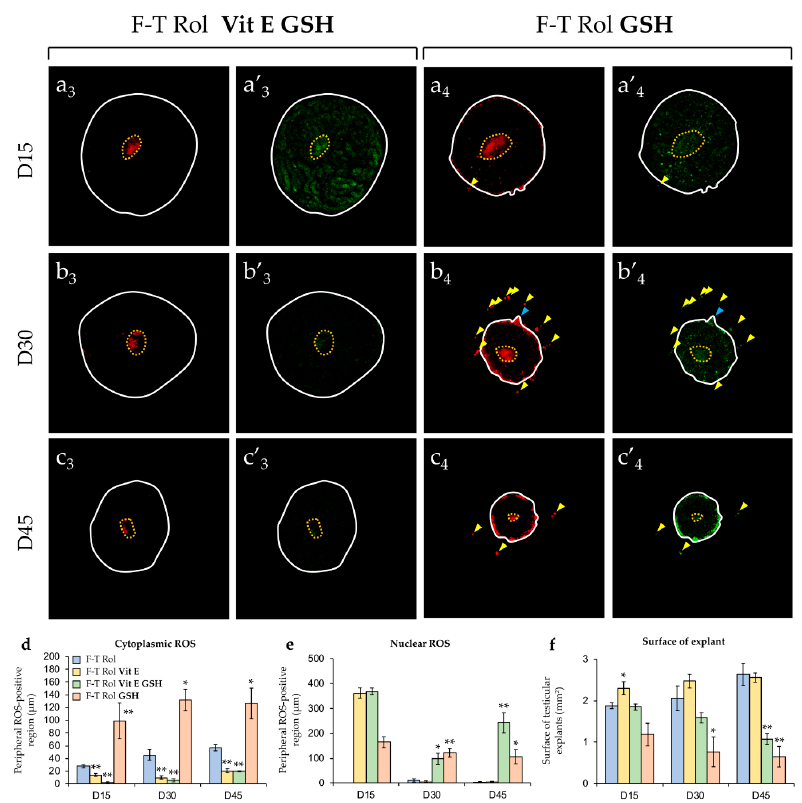
Figure 5. Effect of antioxidant supplementation on “cytoplasmic” and “nuclear” ROS generation in frozen-thawed prepubertal mouse testicular tissue at D15, D30, and D45 of culture using ex vivo imaging by confocal macroscopy. F–T testicular tissues were assessed for “cytoplasmic” ROS generation without ( a 1 , a’ 1 , b 1 , b’ 1 , c 1 , c’ 1 ) or with ( a 2 , a’ 2 , b 2 , b’ 2 , c 2 , c’ 2 ) Vit E (vitamin E), Vit E in combination with glutathione (GSH) ( a 3 , a’ 3 , b 3 , b’ 3 , c 3 , c’ 3 ), or GSH ( a 4 , a’ 4 , b 4 , b’ 4 , c 4 , c’ 4 ). ( d ) The solid line delineates the outline of the testicular explant. The central necrotic area is delimited with a yellow dotted circle. ROS-positive cells (yellow arrows) with the presence of cells outgrowths (blue arrows) were detected outside of the testicular explant for F–T Rol and F-T Rol GSH conditions. Orange signal (orange-fluorescent redox cytoplasmic dye) was detected in the peripheral region of the testicular explants but also in their necrotic central area that was not taken into consideration for fluorescence measurements and is delimited with a yellow dotted circle. Significant decrease of “cytoplasmic” signal intensity could be observed for F-T Rol Vit E when compared with F-T Rol alone, mainly at D30 and D45 of culture. ( e ) Tight peripheral region showing that orange signal could be observed for F-T Rol Vit E GSH at D15, D30, and D45 of culture. However, high signal intensity could be observed for F-T Rol GSH with reduced surface of the tissues mainly at D30 and D45 of culture. Tight peripheral region showing green signal could be observed for F–T Rol at D30 and D45 of culture. ( f ) Weak signal intensity was observed on the whole surface of testicular tissue for F-T Rol Vit E at D15, but the signal intensity significantly decreased at D30 and D45, mainly in the peripheral region of the tissue. High signal intensity was observed for F-T tissue supplemented with Rol, Vit E, and GSH at D15, although it seemed that the signal decreased at D30 and D45. Green signal was observed for F-T Rol GSH at D15 and D30, but increased significantly at D45. The surface of testicular explants were obtained with the detection of a region of interest by the software. A reduction of the explants cultured with F-T Rol Vit E GSH and F-T Rol GSH could be observed. To visualize “cytoplasmic” (orange) and “nuclear” ROS (green) generation in testicular explants, the preparation was illuminated at 530 and 488 nm wavelength, respectively; fluorescence emission was detected from 550 to 580 nm and 500 to 530 nm, respectively. The values ( µ m) are expressed as the mean of the peripheral ROS-positive thickness region ± s.e.m. of “cytoplasmic” or “nuclear” ROS under the di ff erent culture conditions tested, with n = 4. Asterisks indicate a statistically significant di ff erence between fresh BM and fresh Rol or between fresh Rol and F-T Rol (* p < 0.05 and ** p < 0.01). D, day; F-T, frozen-thawed; GSH, reduced glutathione; Rol, retinol; Vit E, vitamin